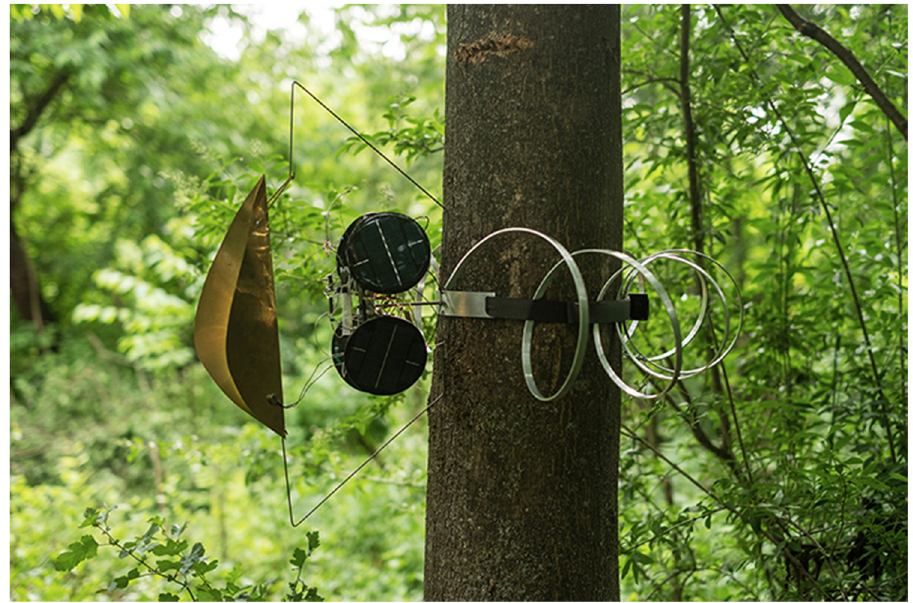
Figure 1: Arboreal Receptors ( 2021 ) , Ioana Vreme Moser. © Maximilian Pramatarov. Courtesy of IMA Institute of Media